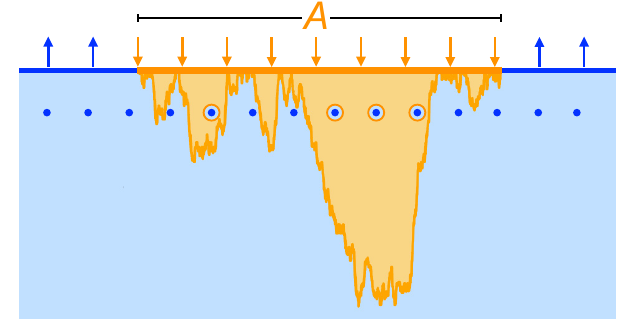
FIG. 2. “Pinning” phase transition. Depolarizing channels close to the final time of the hybrid dynamics leads to an effective attractive potential for the entanglement domain wall. An Ising domain-wall description of the entanglement [9,10], is shown above, which yields a quantitatively inaccurate description of the transition. The numerically observed transition in Sec. II F is consistent with a “pinning” phase transition of a DPRE to an attractive interface